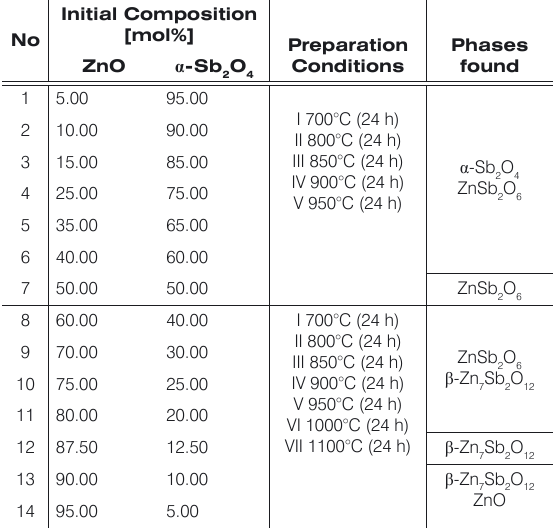
Table 1. Initial mixture composition, preparation conditions and the XRD results after final